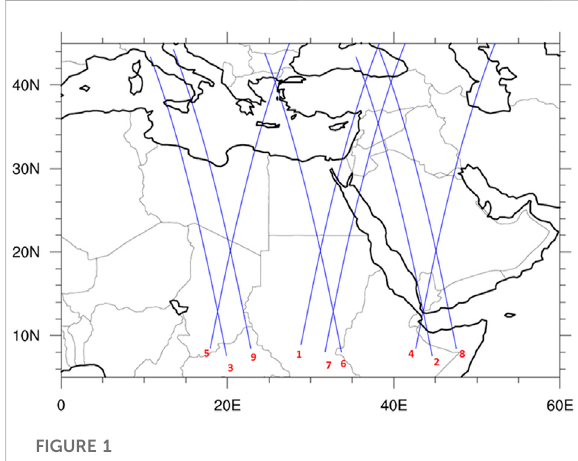
FIGURE 1 Model domain and CALIPSO paths during the dust